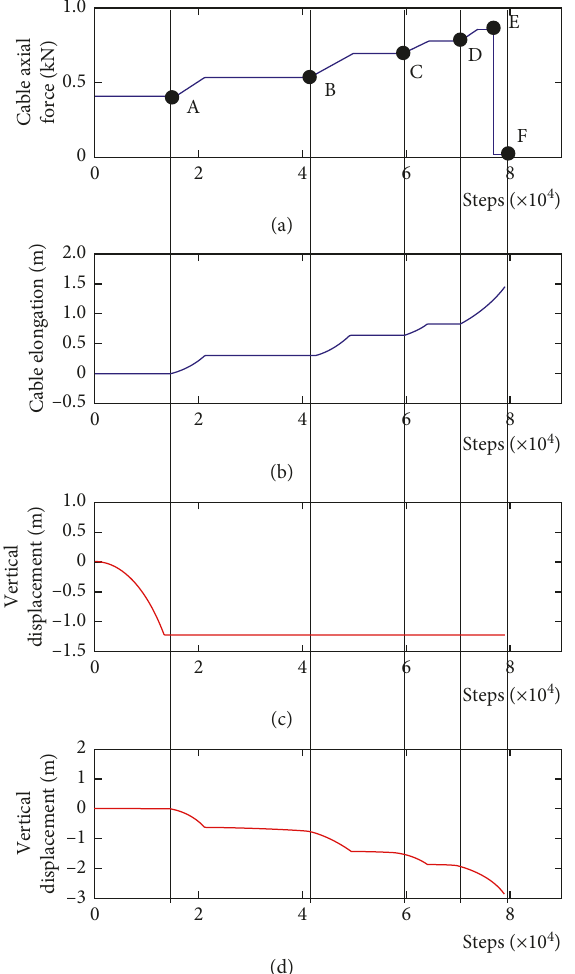
Figure 26: Monitoring curve of 16-1101 landslide by 3DEC software: (a) anchor cable force; (b) anchor cable elongation; (c) vertical relative displacement of monitoring point 1; (d) vertical relative displacement of monitoring point 2.